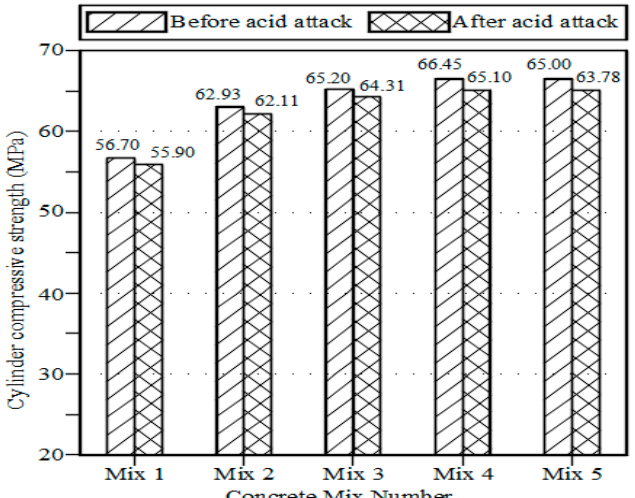
Figure 3. Acid attack test results.